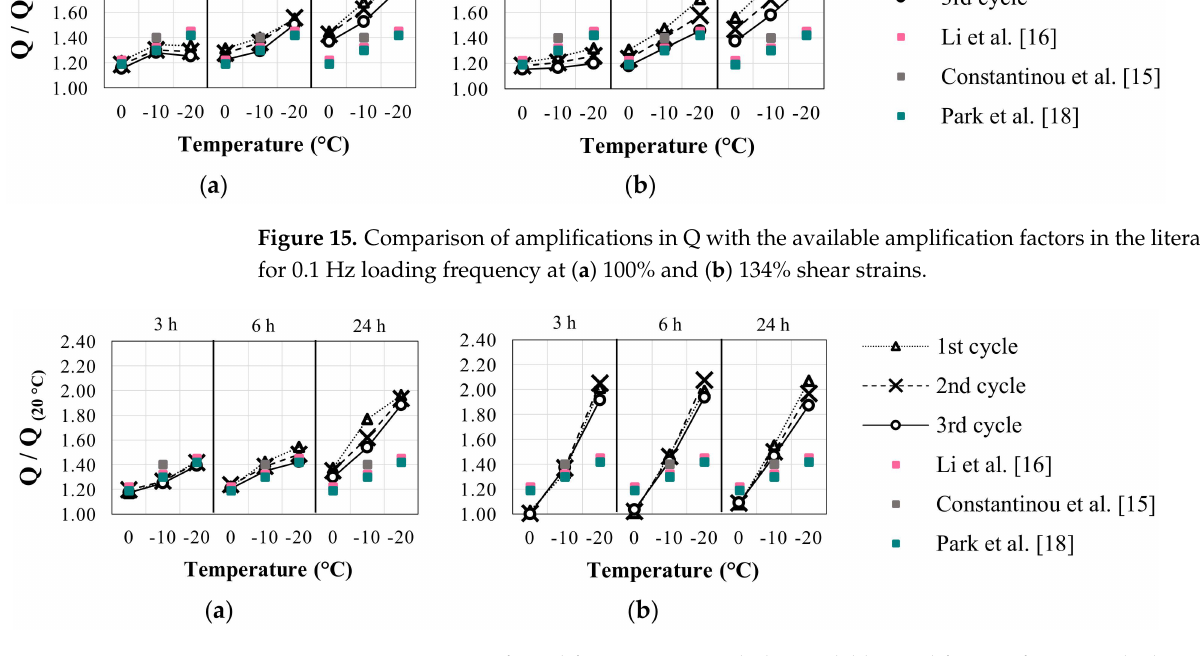
Figure 16. Comparison of amplifications in Q with the available amplification factors in the literature for 0.5 Hz loading frequency at ( a ) 100% and ( b ) 134% shear strains.